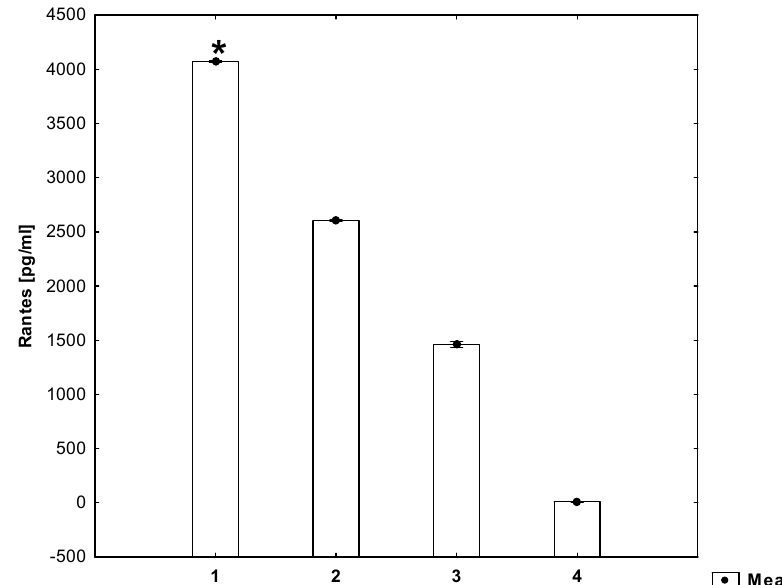
Figure 3. Concentrations of RANTES in the cell culture supernatant (ANOVA). 1—cell suspension + mitogen + homocysteine, 2—cell suspension + mitogen, 3—cell suspension, 4—medium. * statistically significant difference compared to every other group for p ≤ 0.05.